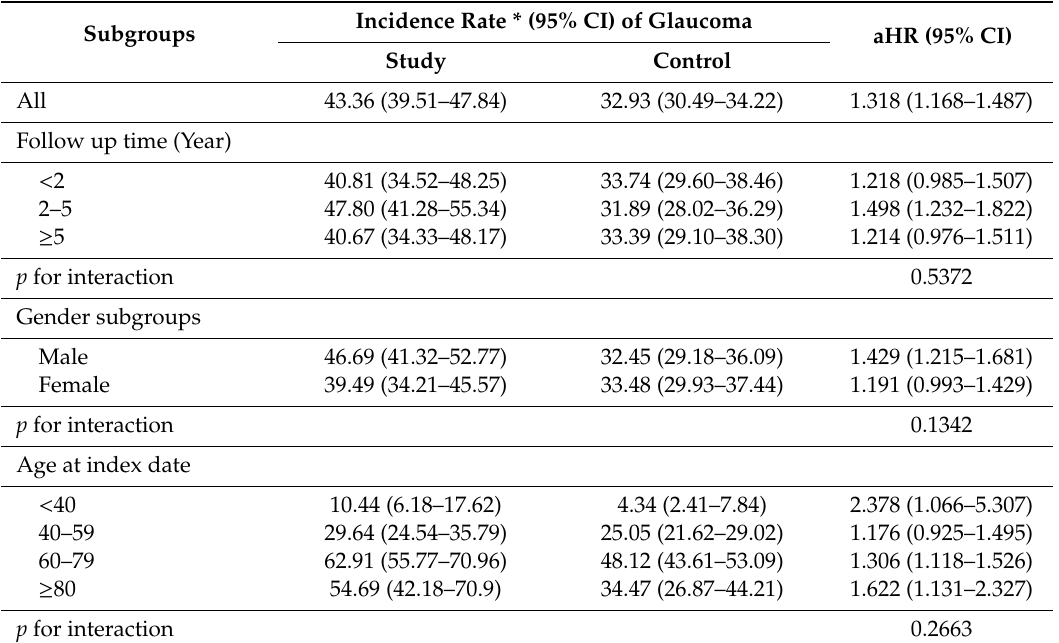
Table 5. The sensitivity analysis for the adjusted hazard ratio of glaucoma stratified by follow up time, gender and age